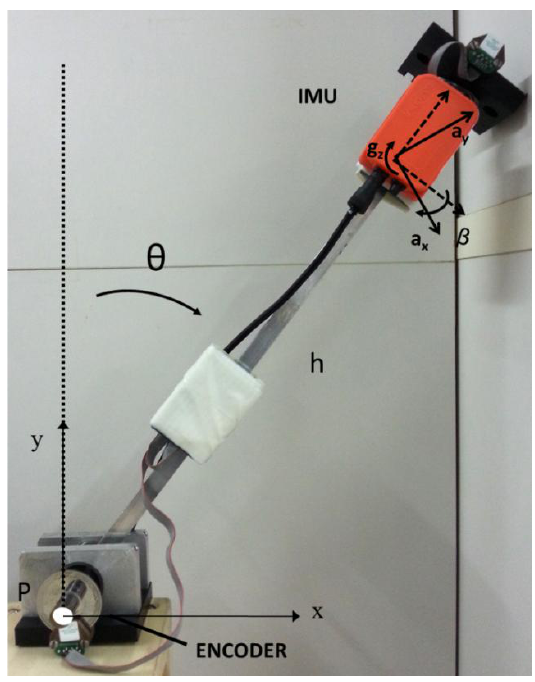
Figure 3. Mechanical Inverted